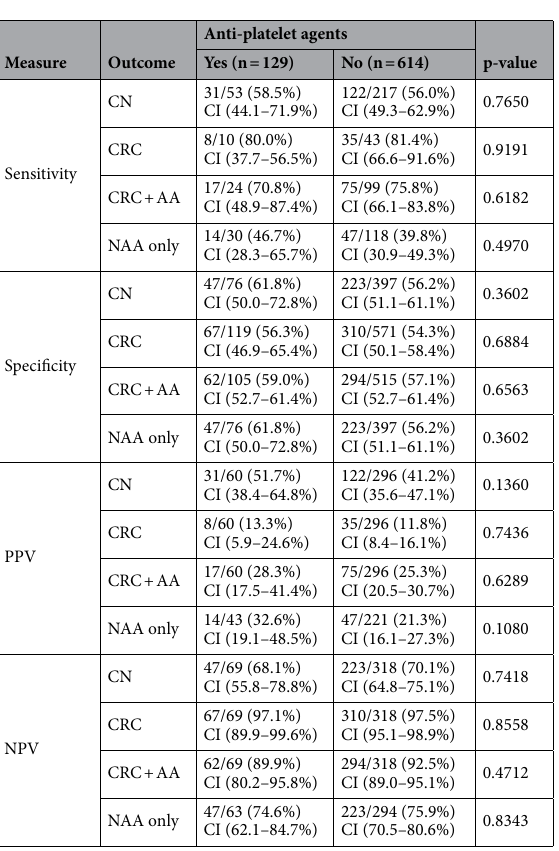
Table 3. Effects of antiplatelet drugs on the results of fecal immunochemical test in colorectal neoplasms screening. CN colorectal neoplasms, CRC colorectal cancer, AA advanced adenoma, NAA non advanced adenoma, PPV positive predictive value, NPV negative predictive value, CI confidence